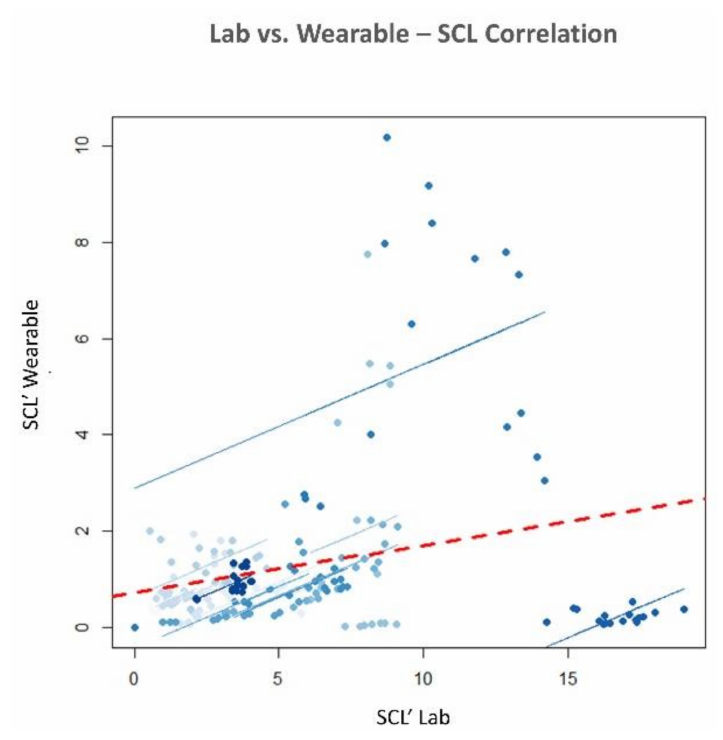
Figure 8. Pearson’s repeated measure correlation for the Skin Conductance Level (SCL) estimated with laboratory and wearable devices. R = 0.4, p < 10 − 6